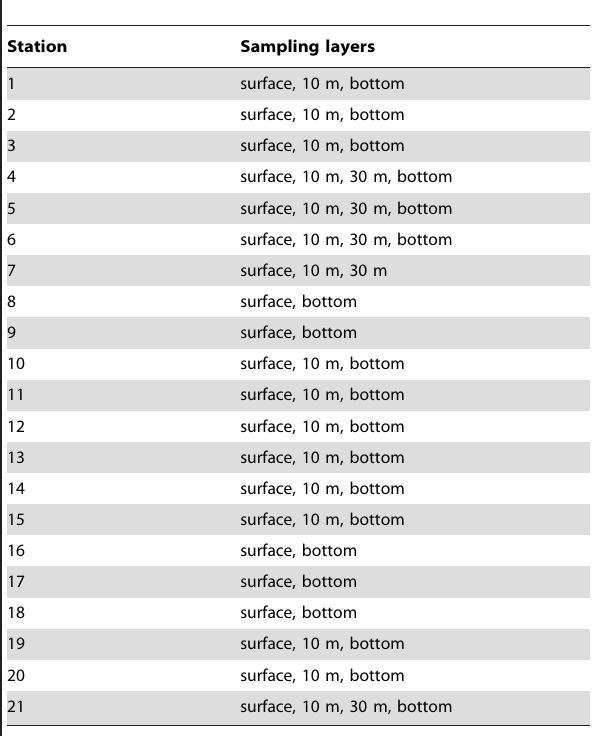
Table 1. Sampling layers in 21 stations for planktonic ciliates in the northern Beibu